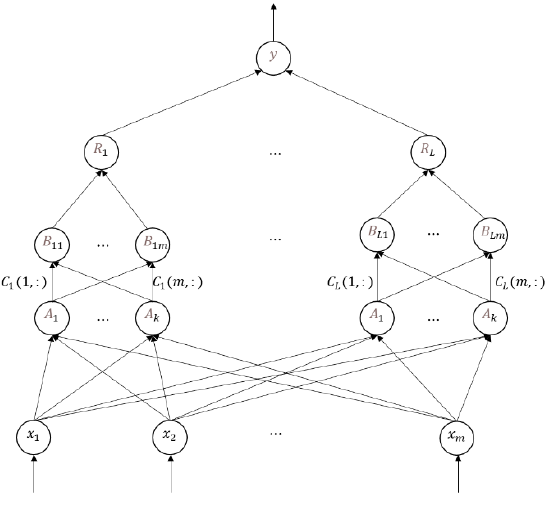
Figure 1. Illustration of the SCFS-IFRs.